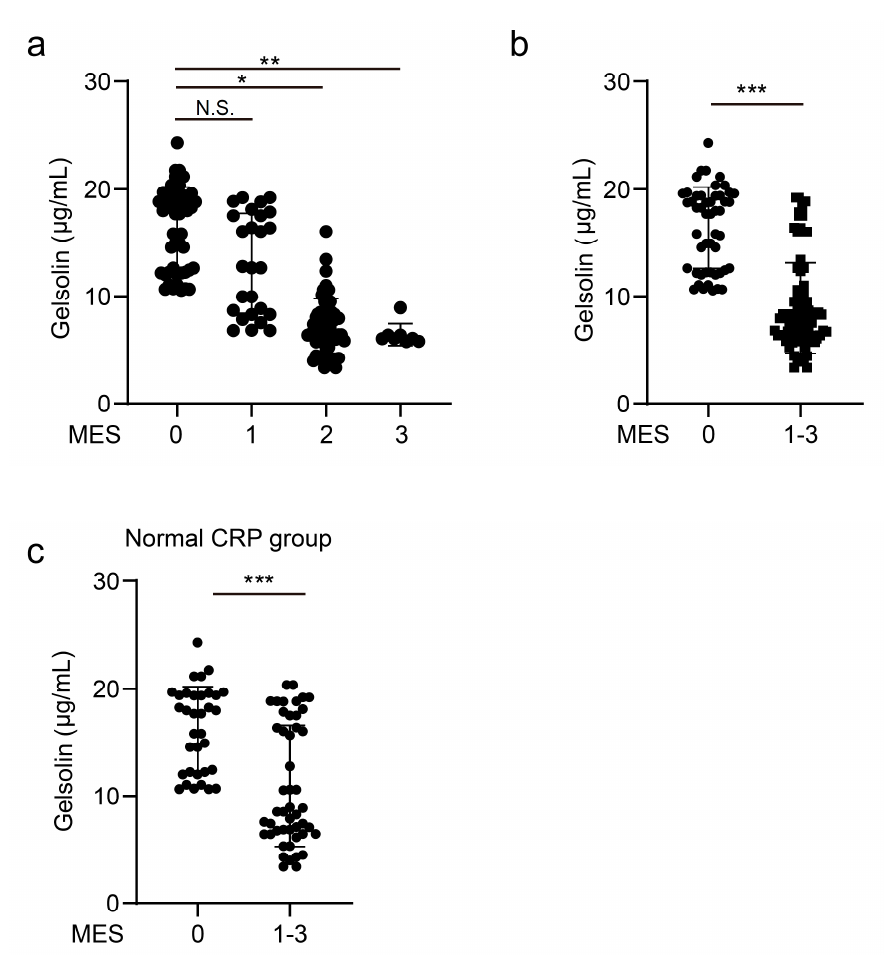
Figure 2. GSN level correlates with the endoscopic activity score in patients with UC. ( a ) Serum GSN level in patients with UC categorized according to disease activity (MES 0 ( n = 50), 1 ( n = 26), 2 ( n = 54), and 3 ( n = 8)). ( b ) Serum GSN level in 50 patients with UC in endoscopic remission (Mayo endoscopic score (MES) = 0) and 88 patients with endoscopically active UC (MES > 0). ( c ) Serum GSN level was measured in 34 patients with UC in endoscopic remission and 48 patients with endoscopically active UC and normal CRP level (CRP < 0.14 mg/dL). Statistical significance was defined as p < 0.05 (* p < 0.05; ** p < 0.01; *** p < 0.001; and N.S., not significant) using Mann–Whitney